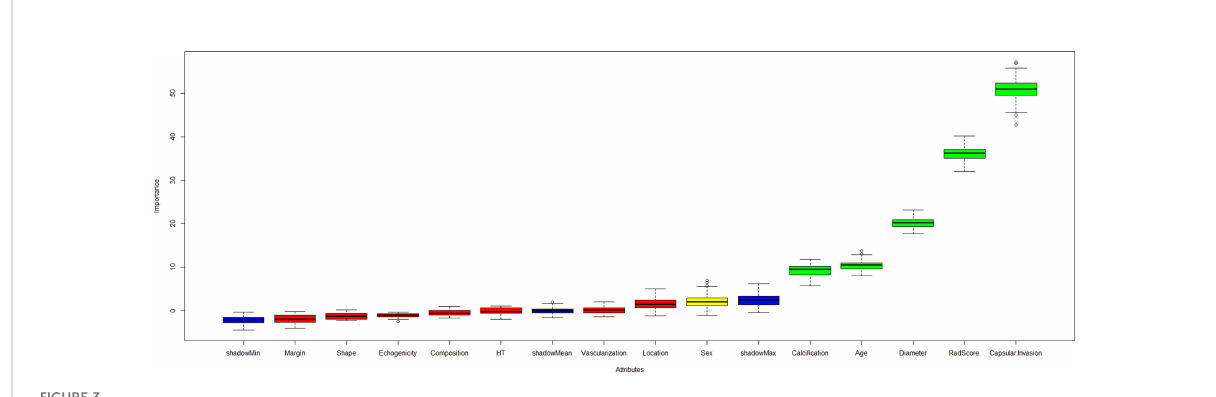
FIGURE 3 The Boruta algorithm incorporating the independent clinical, ultrasound variables and radiomics score was performed to select the fi nal predictors for CCLNM. The key features included capsular invasion, radiomics score, diameter, age, and calci fi